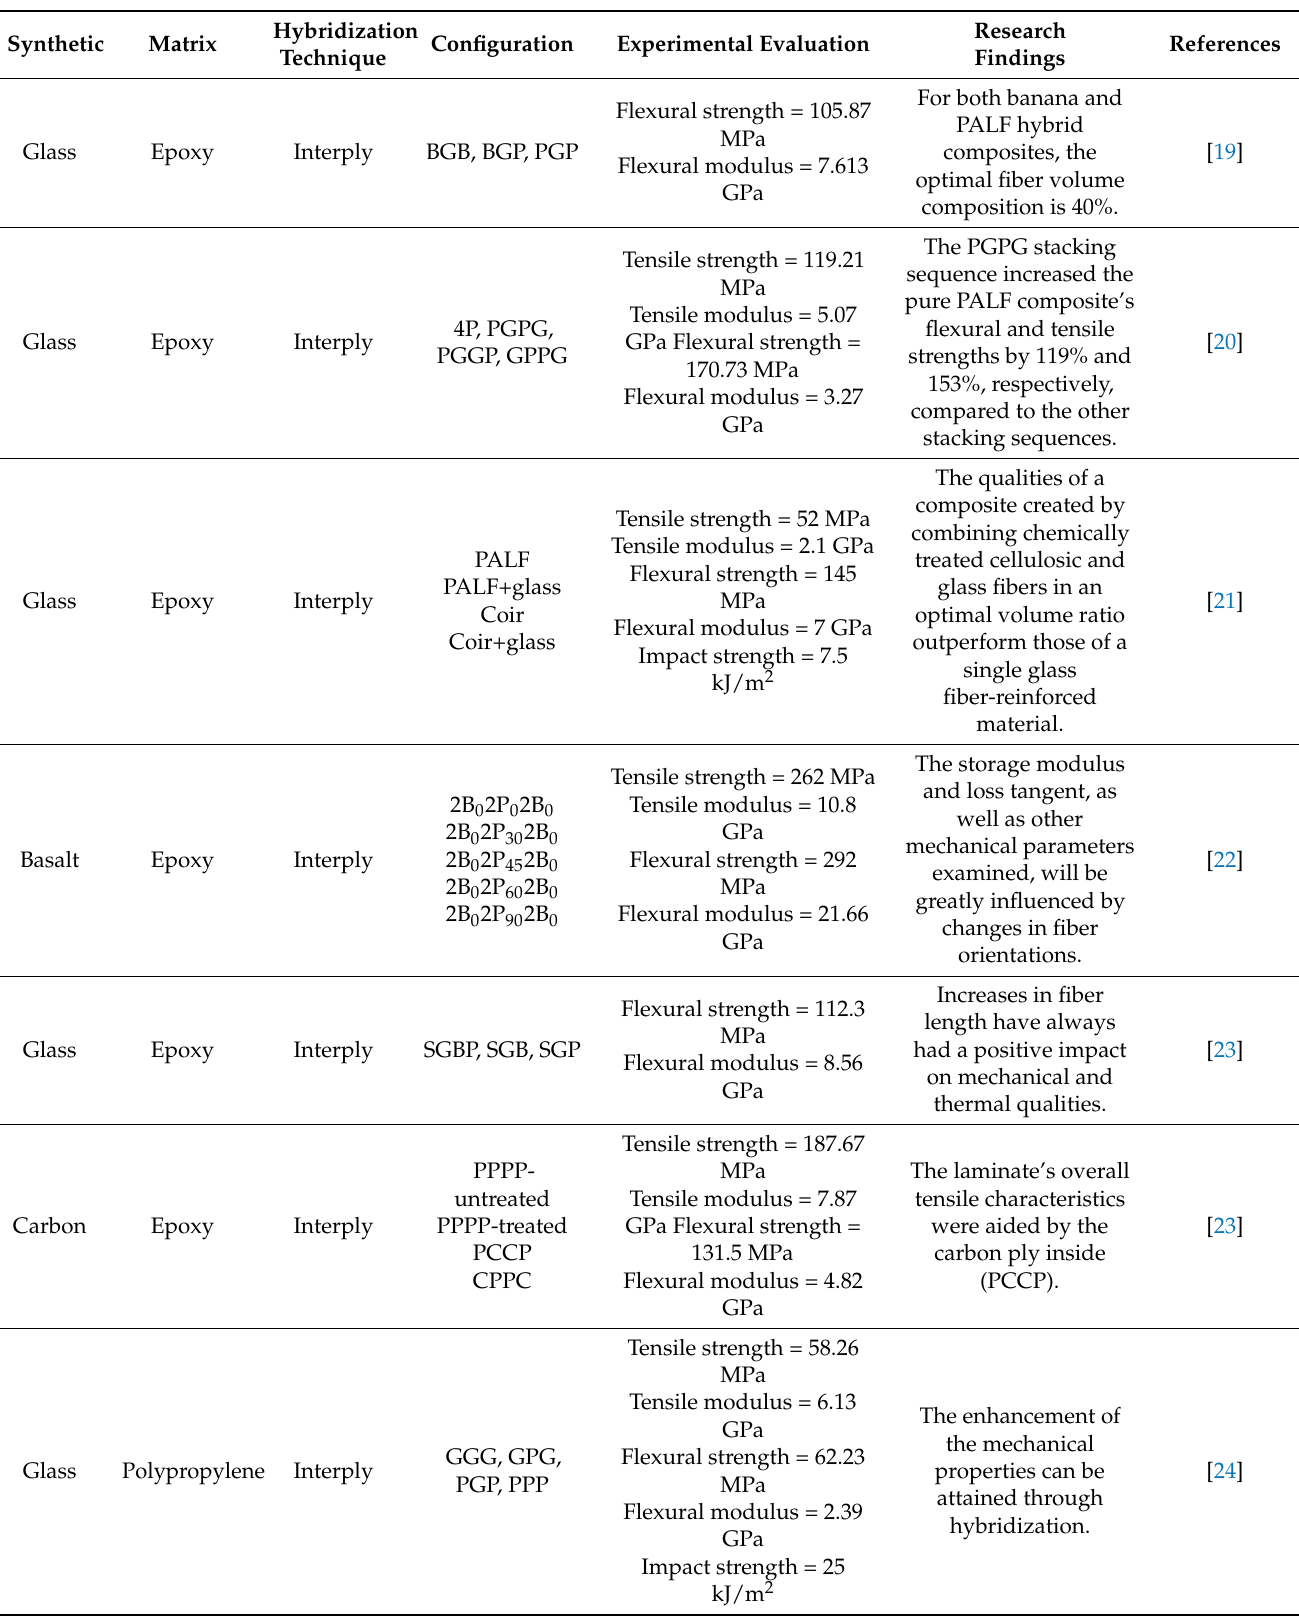
Table 1. Research works reported on PALF hybrid composite